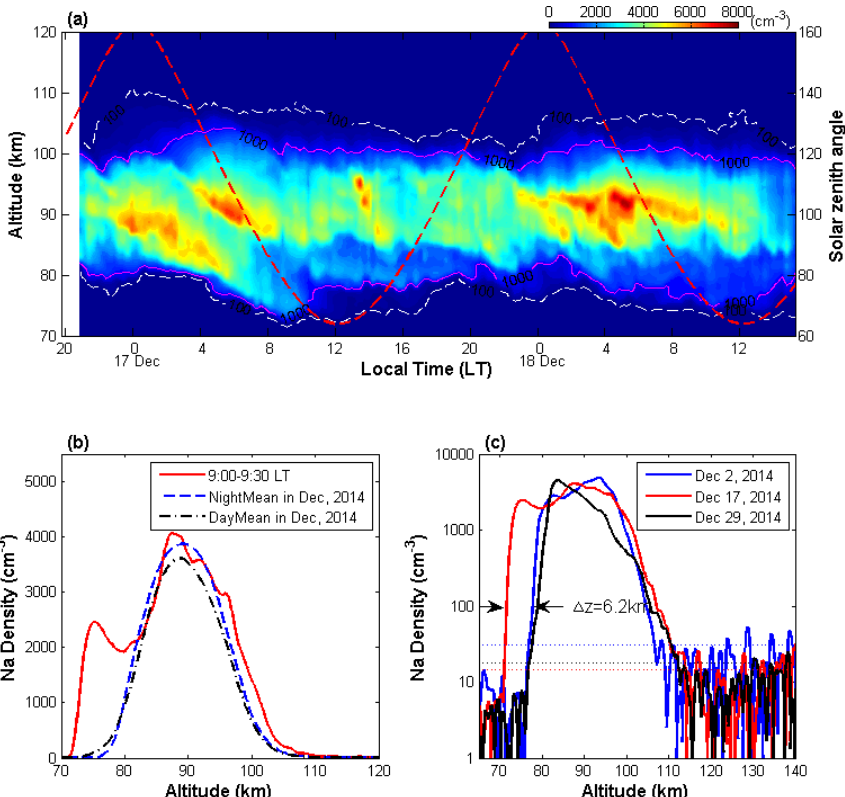
Figure 2. (a) Contours of Na density versus local time and altitude observed from ∼ 21:00LT on 16 December to ∼ 16:00LT on 18 December 2014. The time resolution is 15min, and altitude resolution is 960m. (b) Comparison of Na density profiles averaged at 09:00–09:30LT on 17 December (red solid line), and averaged during daytime (07:00–17:00LT, black dotted line) and nighttime (17:00–07:00LT, blue dashed line) in December 2014. (c) Comparison of Na density profiles on 17 December (red curve) with those on 2 December (blue curve) and 29 December (black curve). The horizontal dotted lines are their respective detection limits, whose values from small to large are ∼ 15, 19, 31cm − 3